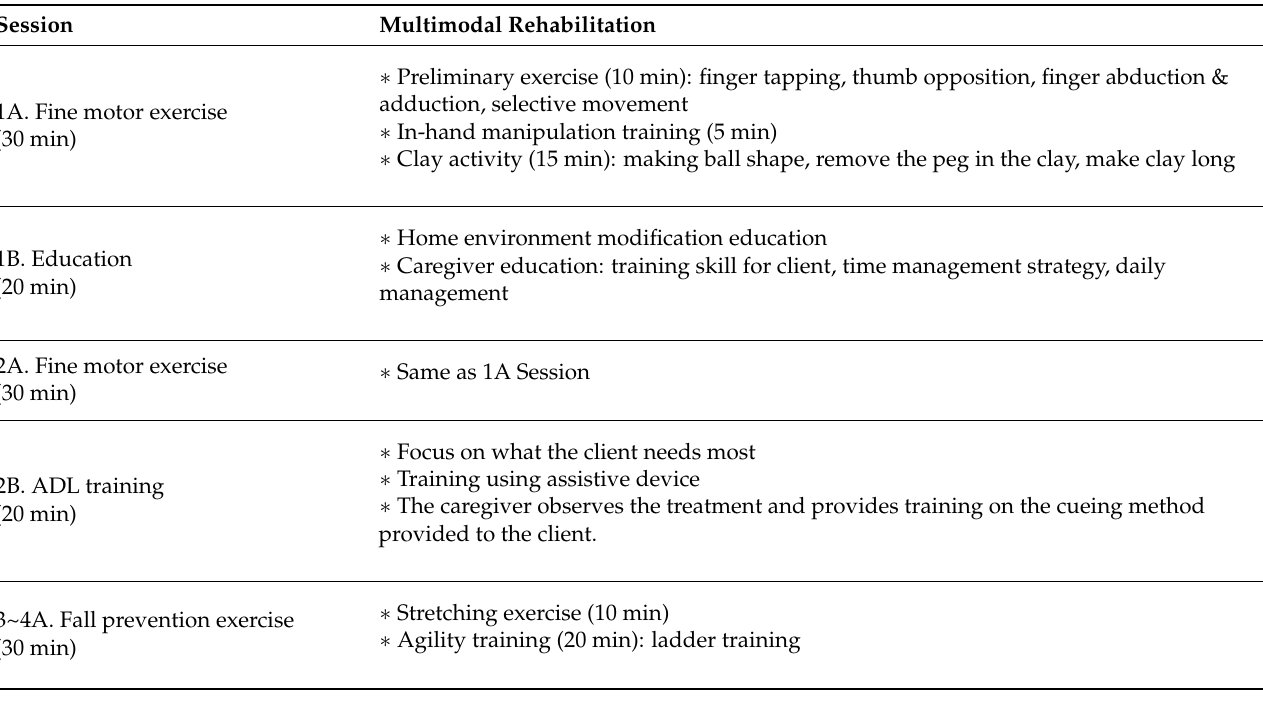
Figure 1. Study design. Table 1. Multimodal